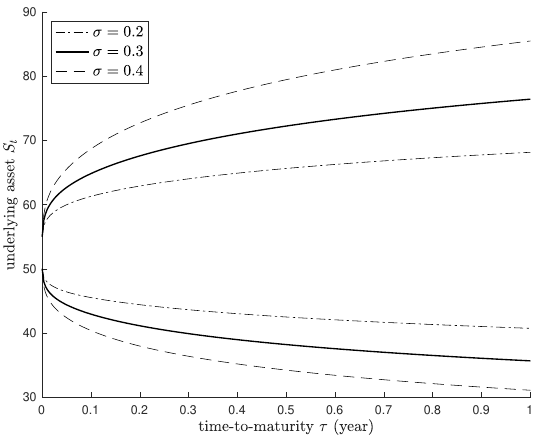
Figure 4. Two free boundaries Z up ( t ) and Z low ( t ) with respect to σ